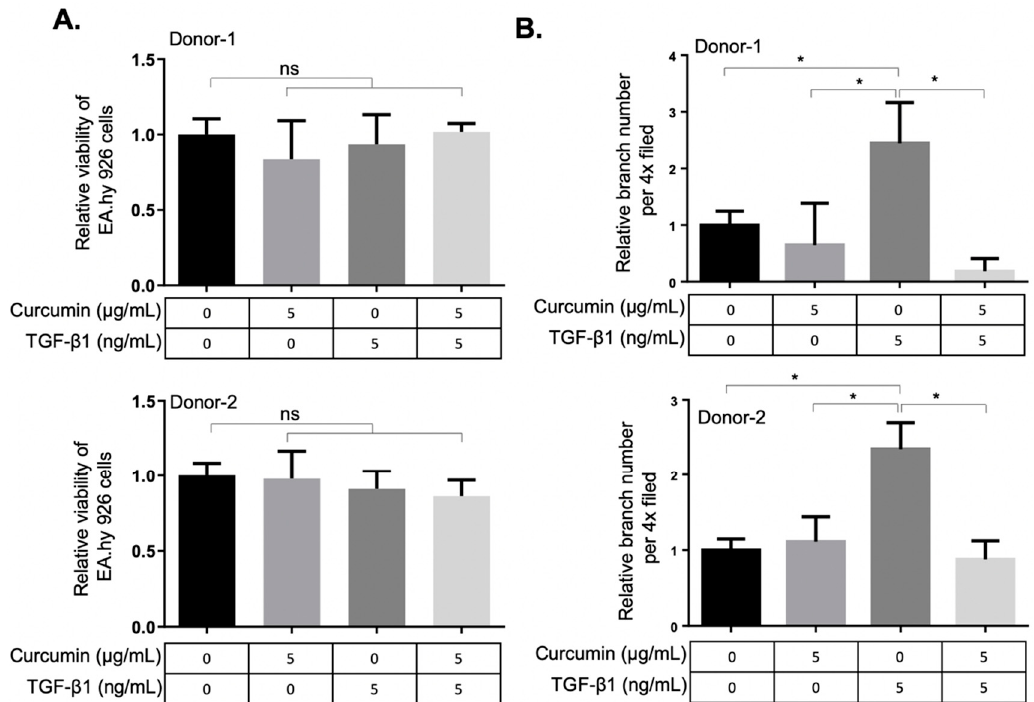
Figure 4. Curcumin suppresses the TGF- β 1-mediated angiogenic activity in EA.hy926 endothelial cells. ( A ) Viability of EA.hy926 endothelial cells (ECs) was measured after treatment with conditioned medium from curcumin or TGF- β 1-treated orbital fibroblasts. The fibroblasts were seeded in 10% FBS-containing medium overnight and then treated with curcumin or TGF- β 1 for 24 h. The medium was then discarded and replenished with the basal DMEM for an additional 24 h as the conditioned medium for treatment of ECs. Data are expressed as the mean ± SD ( n = 3). ns, not significant. ( B ) The relative tube-branching numbers of ECs cultured at indicated conditioned medium from orbital fibroblasts. (4× field) Data are expressed as the mean ± SD ( n > 3). *, p < 0.05.